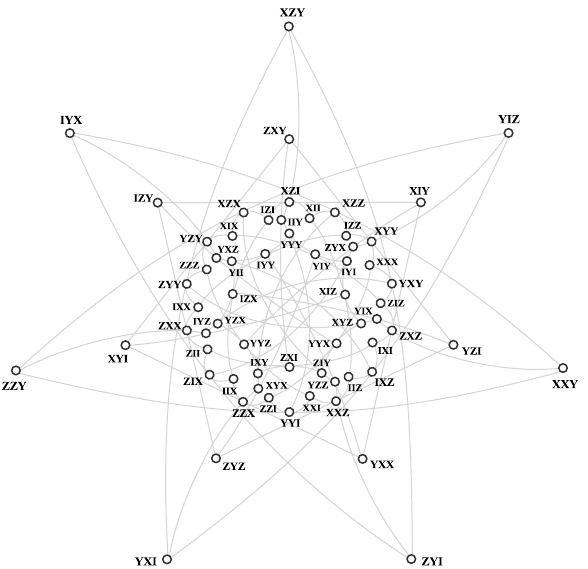
Figure 6. Three-qubit classical embedding of the split Cayley hexagon of order two as described in 29 . The illustration of points and lines of the hexagon follows closely that of Ref. 38